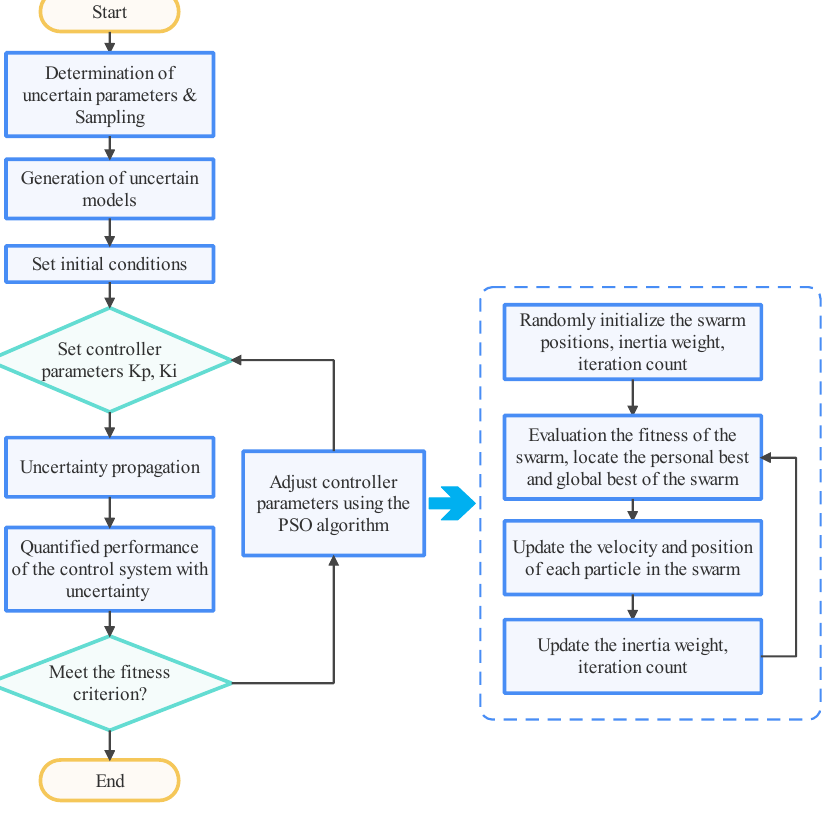
Figure 6. Flowchart of the design of the uncertainty-based control